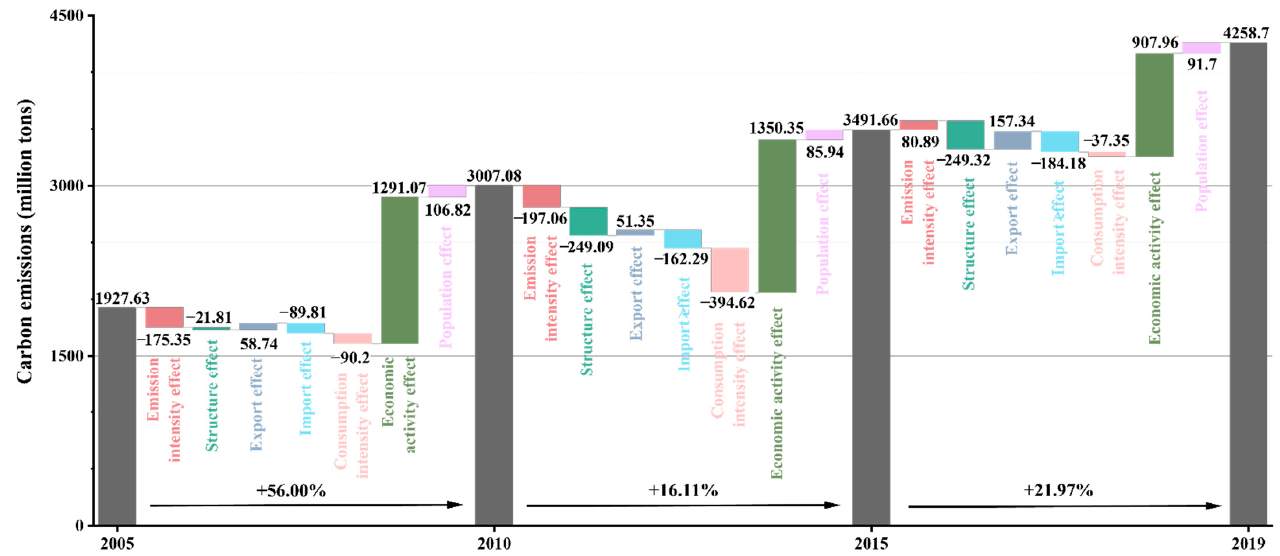
Figure 6. Contributions of different factors to carbon emissions of China’s power industry in 2005– 2010, 2010–2015, and 2015–2019.